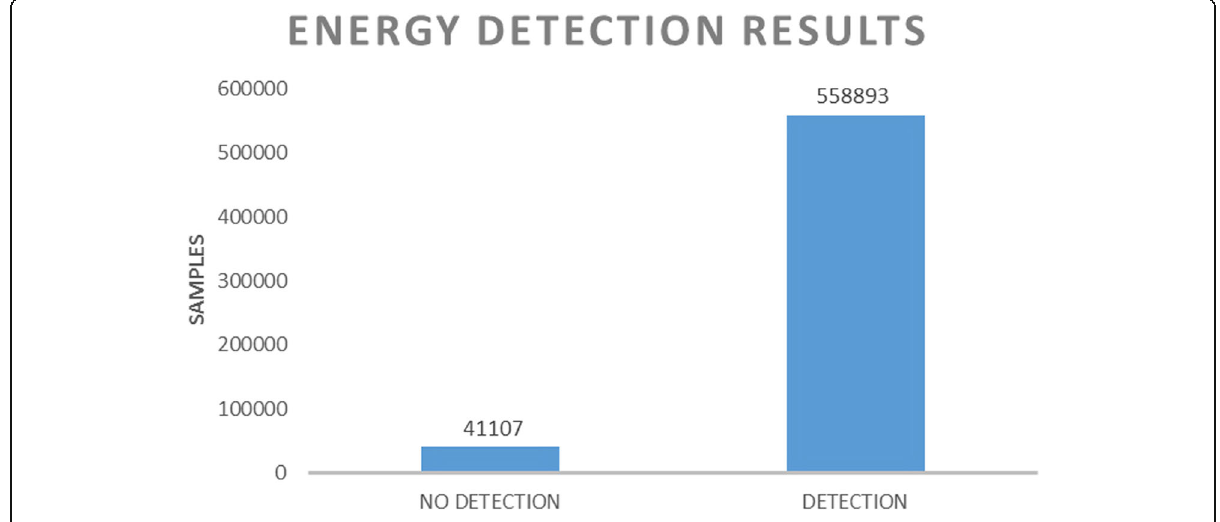
Fig. 13 Energy detection results